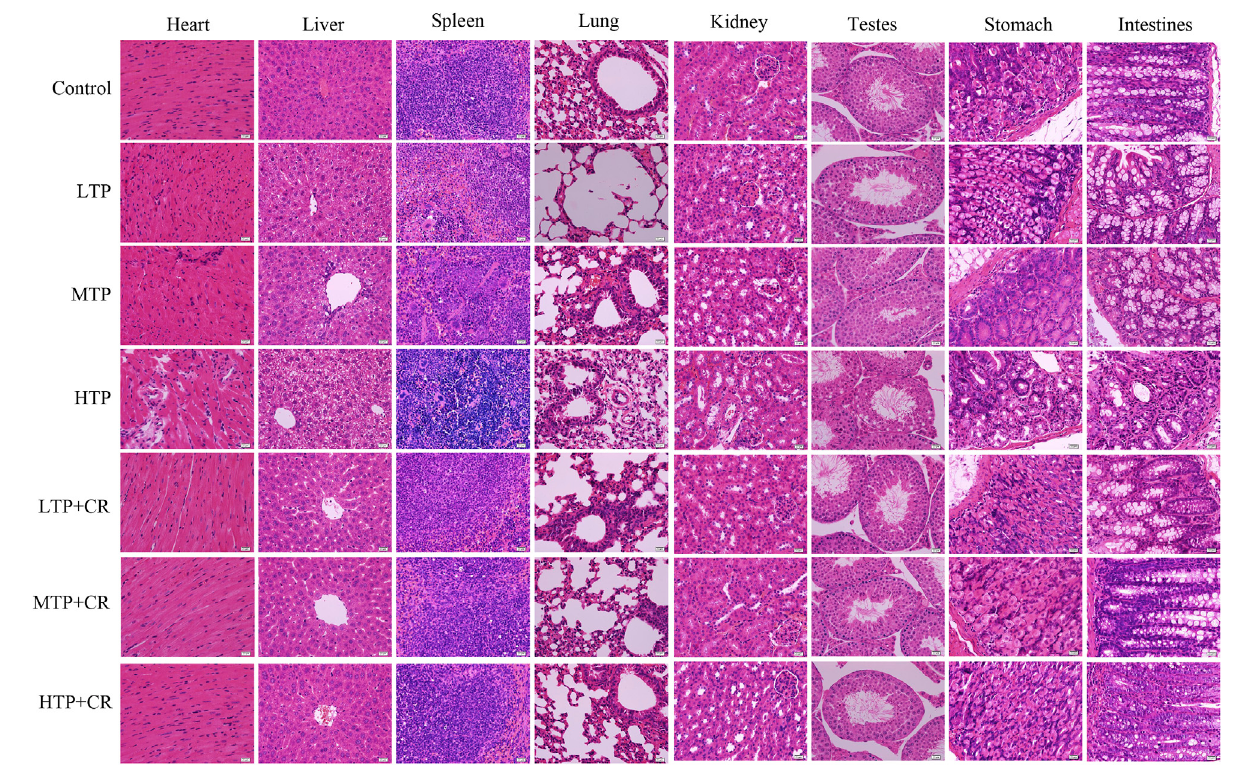
Frontiers in Pharmacology |